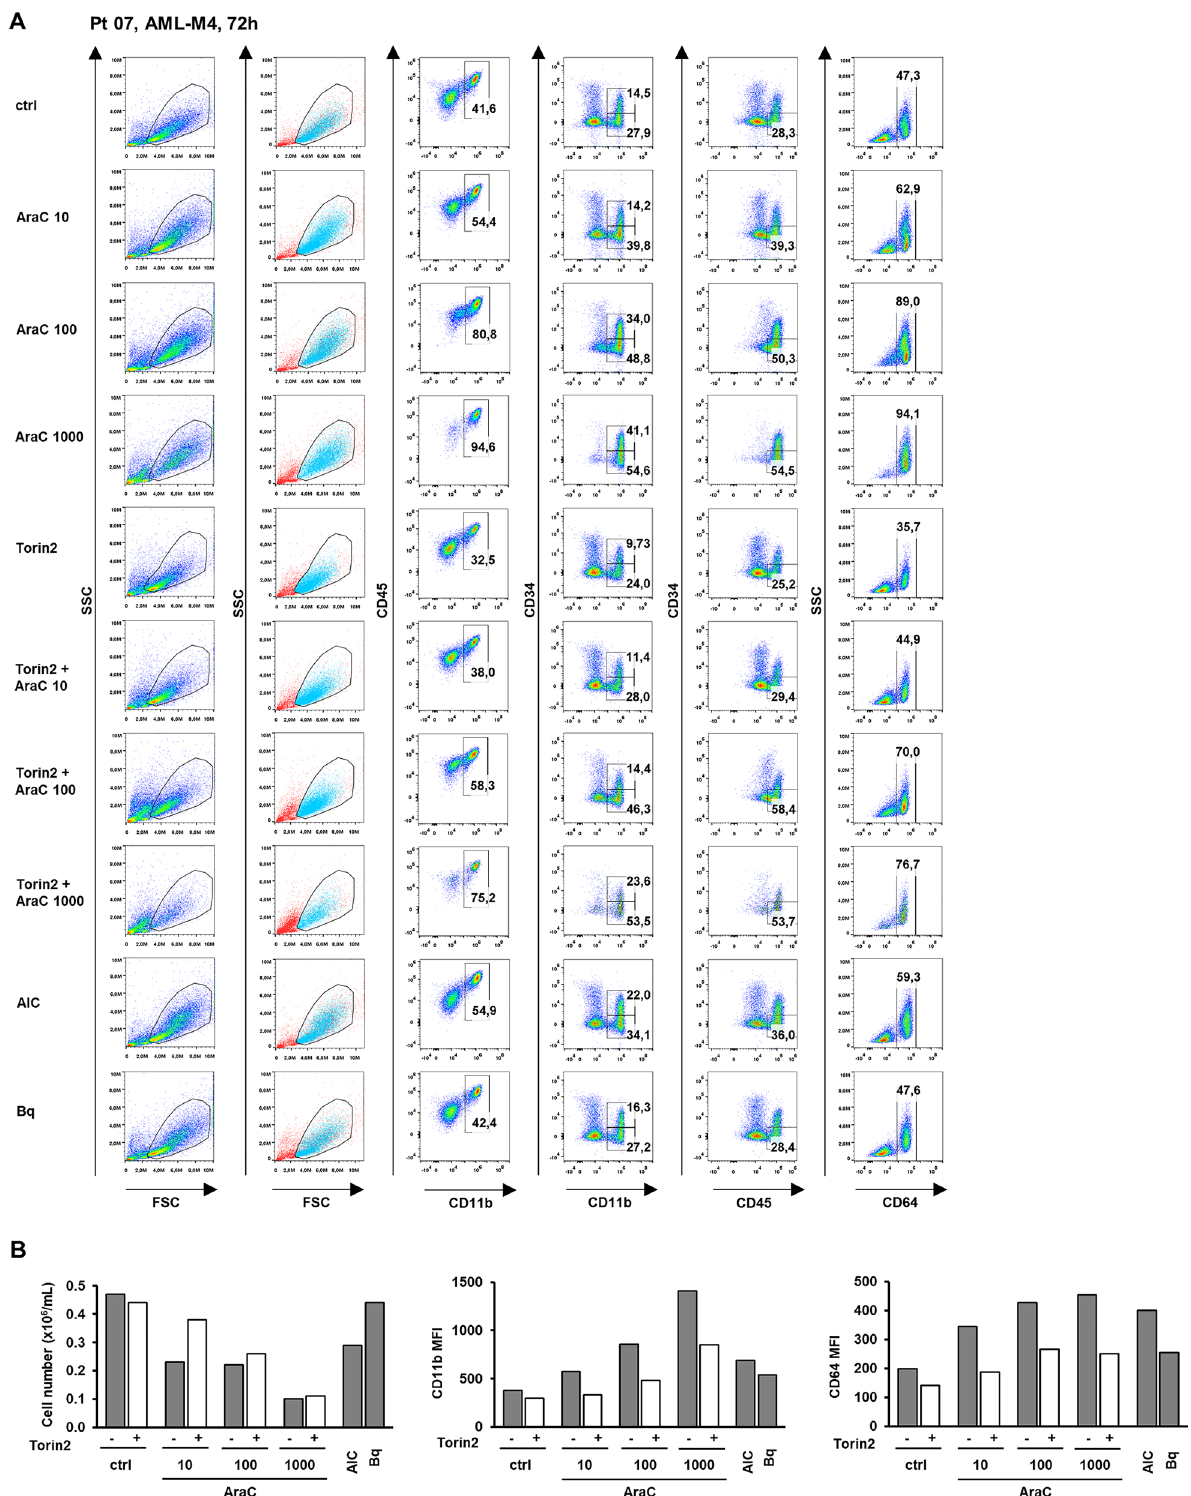
Figure 6. Cytarabine dose-dependently increases expression of differentiation markers in a primary sample from AML-M4 patient that was responsive to pyrimidine synthesis inhibition. Non-adherent mononuclear cells from bone marrow sample (Pt 07, normal karyotype, FLT3 -ITD, NPM /mut) were plated at concentration 0.4 × 10 6 /mL in medium supplemented with 50 ng/mL IL-3, IL-6, SCF and FLT3L and incubated with AraC (10, 100, 1000 nM) with or without Torin2 (10 nM) for 72 h. AICAr (AIC) (0.2 mM) and brequinar (Bq) (0.5 µM) were used as a positive control. Data shown are from a single experiment. ( A ) Flow cytometric analysis of CD11b + CD45 + , CD11b + CD34 + and CD11b + CD34 - , CD45 high CD34 − , and CD64 + populations. Percentage of cells in population of interest is indicated in respective gates. Cells within the gate that stained negative for 7-AAD are shown in blue. ( B ) The number of viable cells was determined by trypan blue exclusion. Mean fluorescence intensity (MFI) of CD11b and CD64 was calculated as described under “Methods”